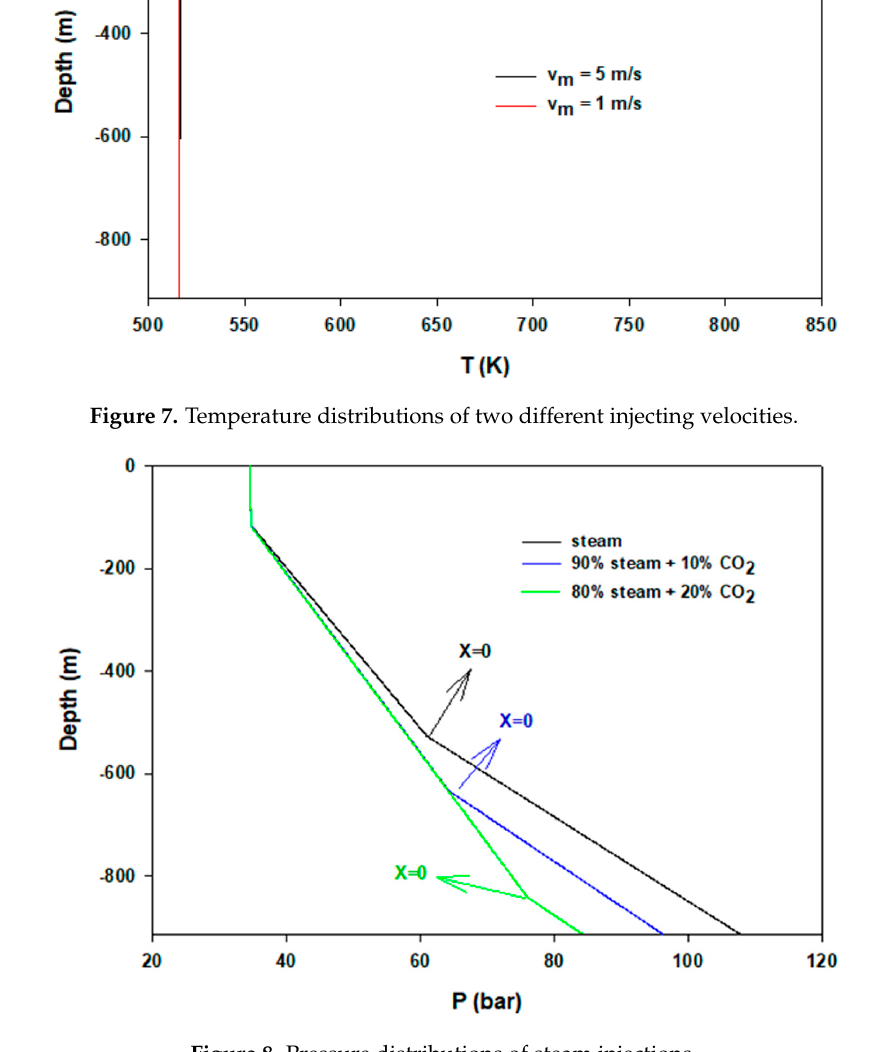
Figure 8. Pressure distributions of steam injections.